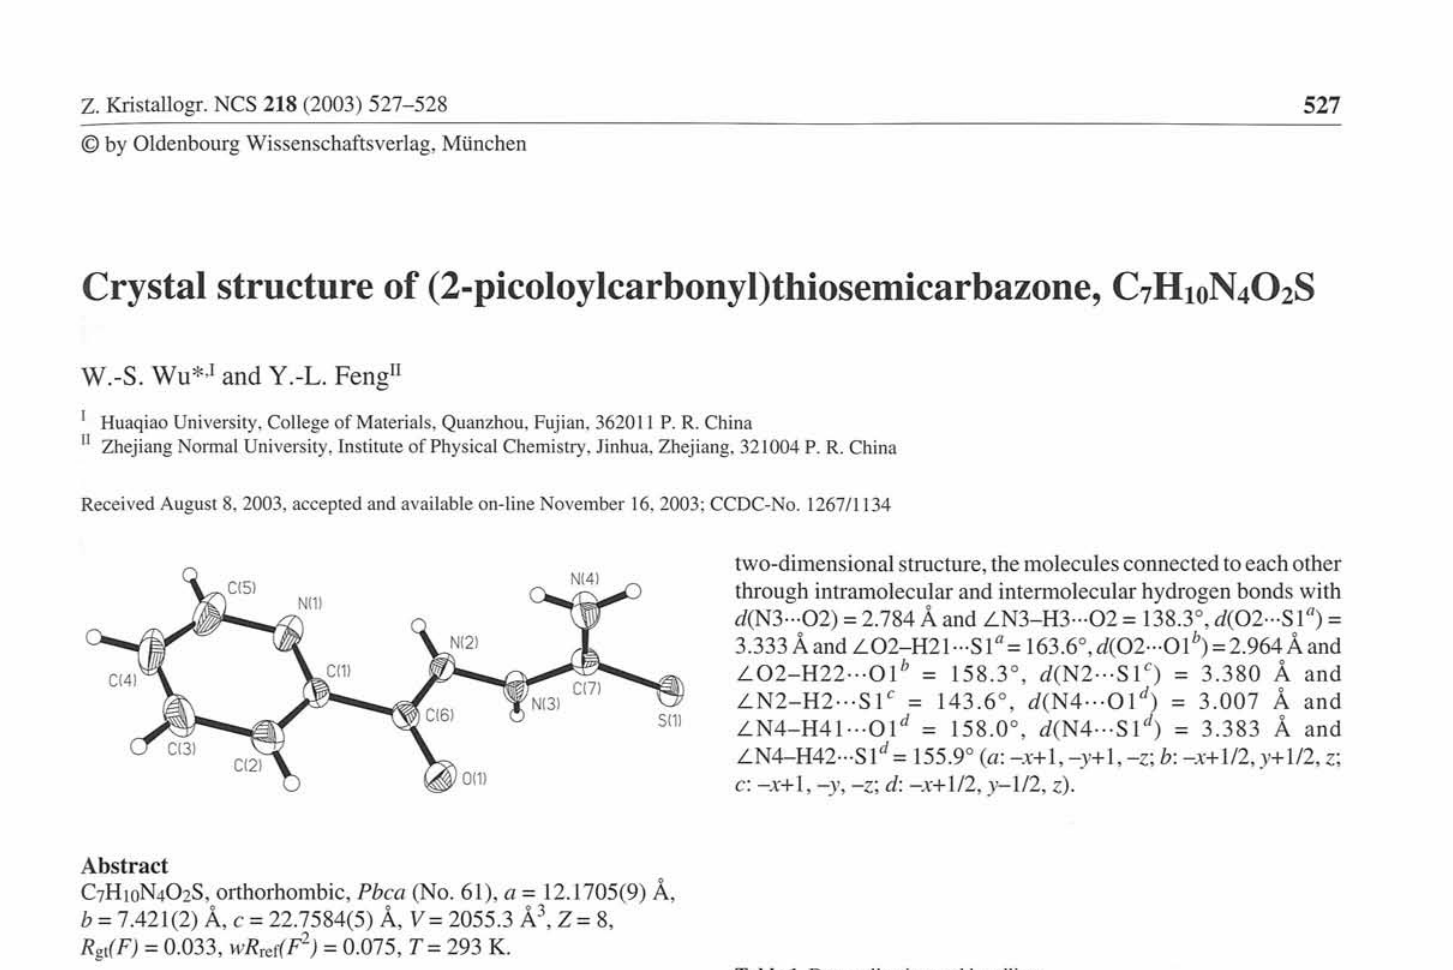
Table 1. Data collection and handling.